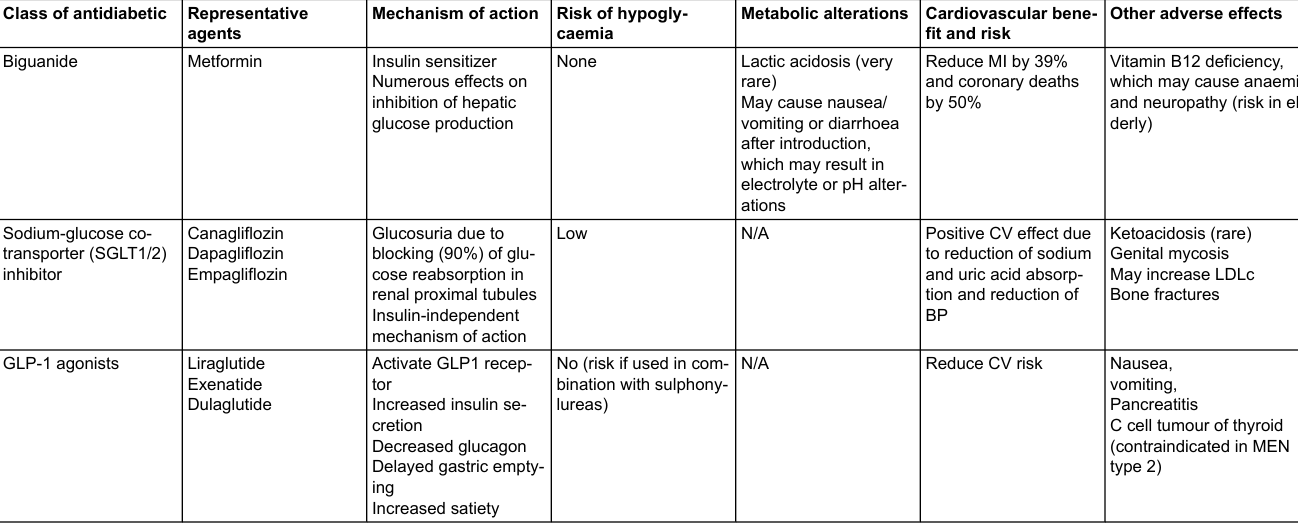
Table 1: Pharmacological adjuvants for glycaemic control. Class of antidiabetic Representative Mechanism of action Risk of hypogly- Metabolic alterations Cardiovascular bene- agents caemia fit and